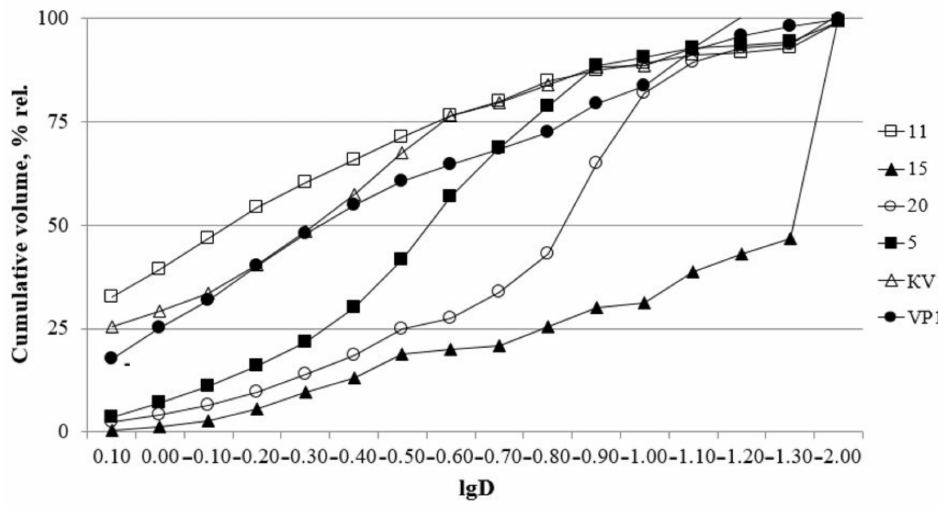
Figure 2. Cumulative curves. D—particle diameter,